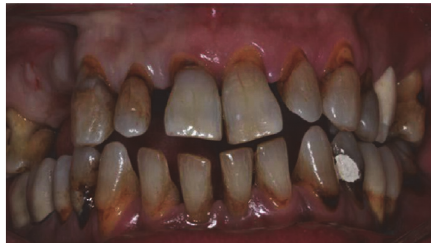
Figure 1: Starting case, clinical frontal view of the patient.